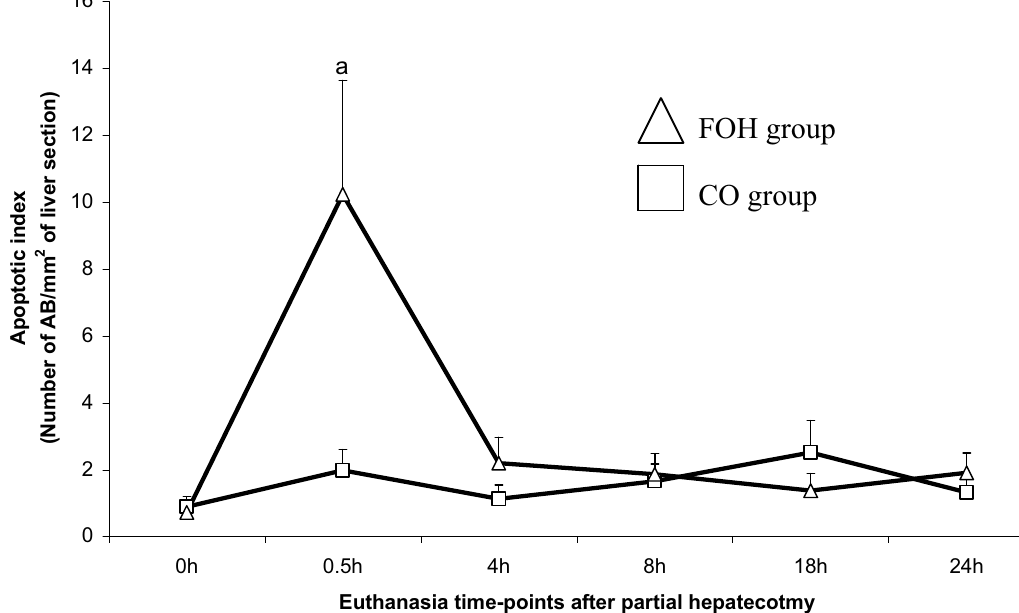
FIGURE 4 - Hepatic apoptosis index (AI) of rats treated with CO or FOH for 2 consecutive weeks and submitted to PH. In both CO and FOH treatment, the number of animals analyzed varied from 8 to 9 in each euthanasia time-point. Data are means ± SEM. Statistics by two-way ANOVA followed by Tukey test: a) statistically different from CO group in the same euthanasia